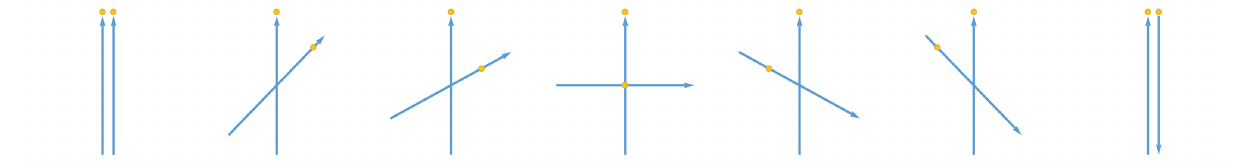
Figure 8: Average View for the Spin Triplet States. Reading from left to right, as Bob rotates his SG magnets relative to Alice’s SG magnets for her + 1 outcome, the average value of his outcome varies from + 1 (totally up, arrow tip) to 0 to − 1 (totally down, arrow bottom). This obtains per conservation of spin angular momentum on average in accord with no preferred reference frame. Bob can say exactly the same about Alice’s outcomes as she rotates her SG magnets relative to his SG magnets for his + 1 outcome. That is, their outcomes can only satisfy conservation of spin angular momentum on average in di ff erent reference frames, because they only measure ± 1 , never a fractional result. Again, just as with the light postulate of special relativity, we see that no preferred reference frame leads to a counterintuitive result. Here it requires quantum outcomes ± 1 measurements leading to the “mystery” of “average-only” conservation. Reproduced from Silberstein et al. [27].